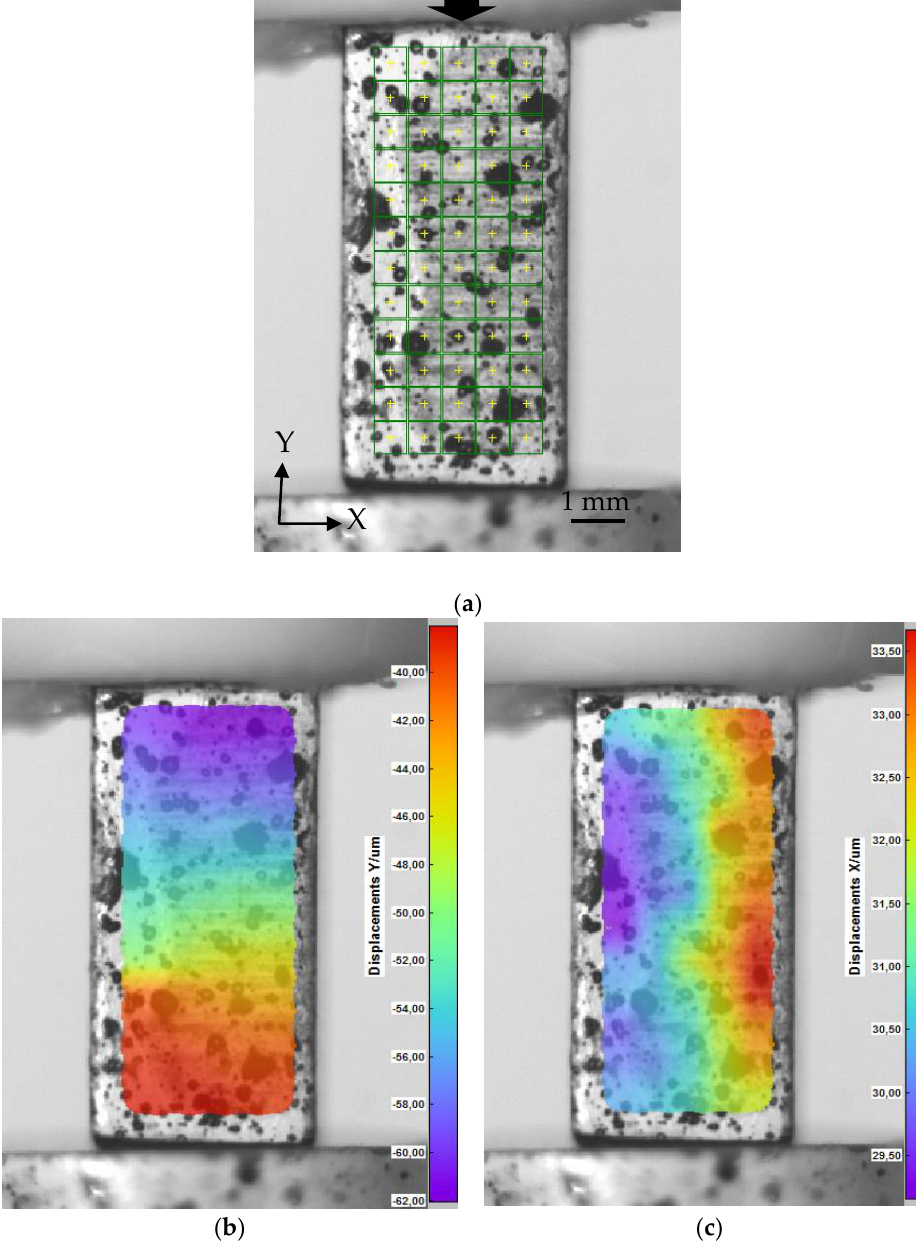
Figure 1. ( a ) Evaluated surface of (La 0.6 Sr 0.4 ) 0.95 Co 0.2 Fe 0.8 O 3-δ (LSCF)-P20/50 MPa sample with depicted facets used for the evaluation, ( b ) axial and ( c ) lateral color map displacements at maximum load.